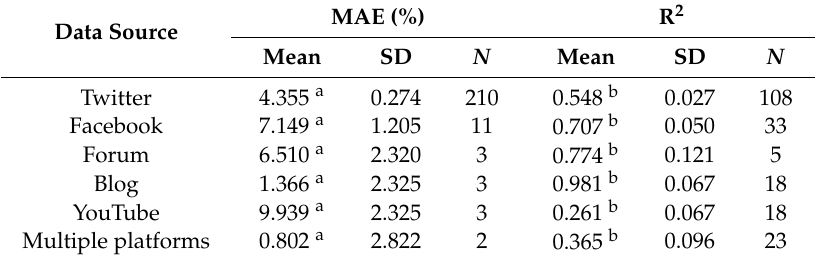
Table 4. Covariate-adjusted means of predictions across data sources.